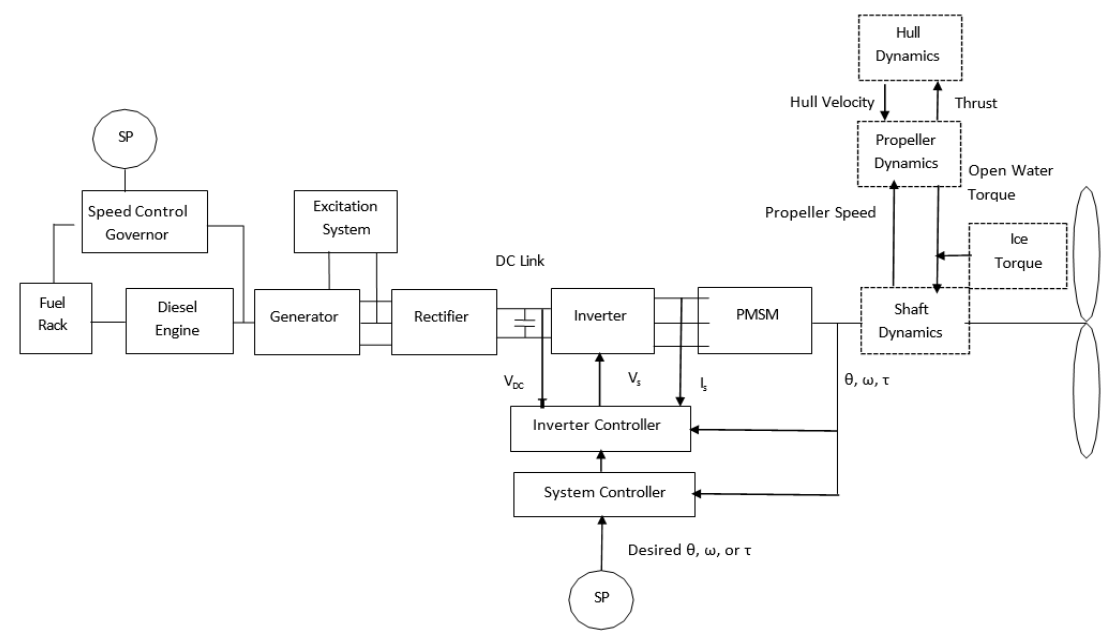
Figure 3. Functional Diagram of the Full System Model.